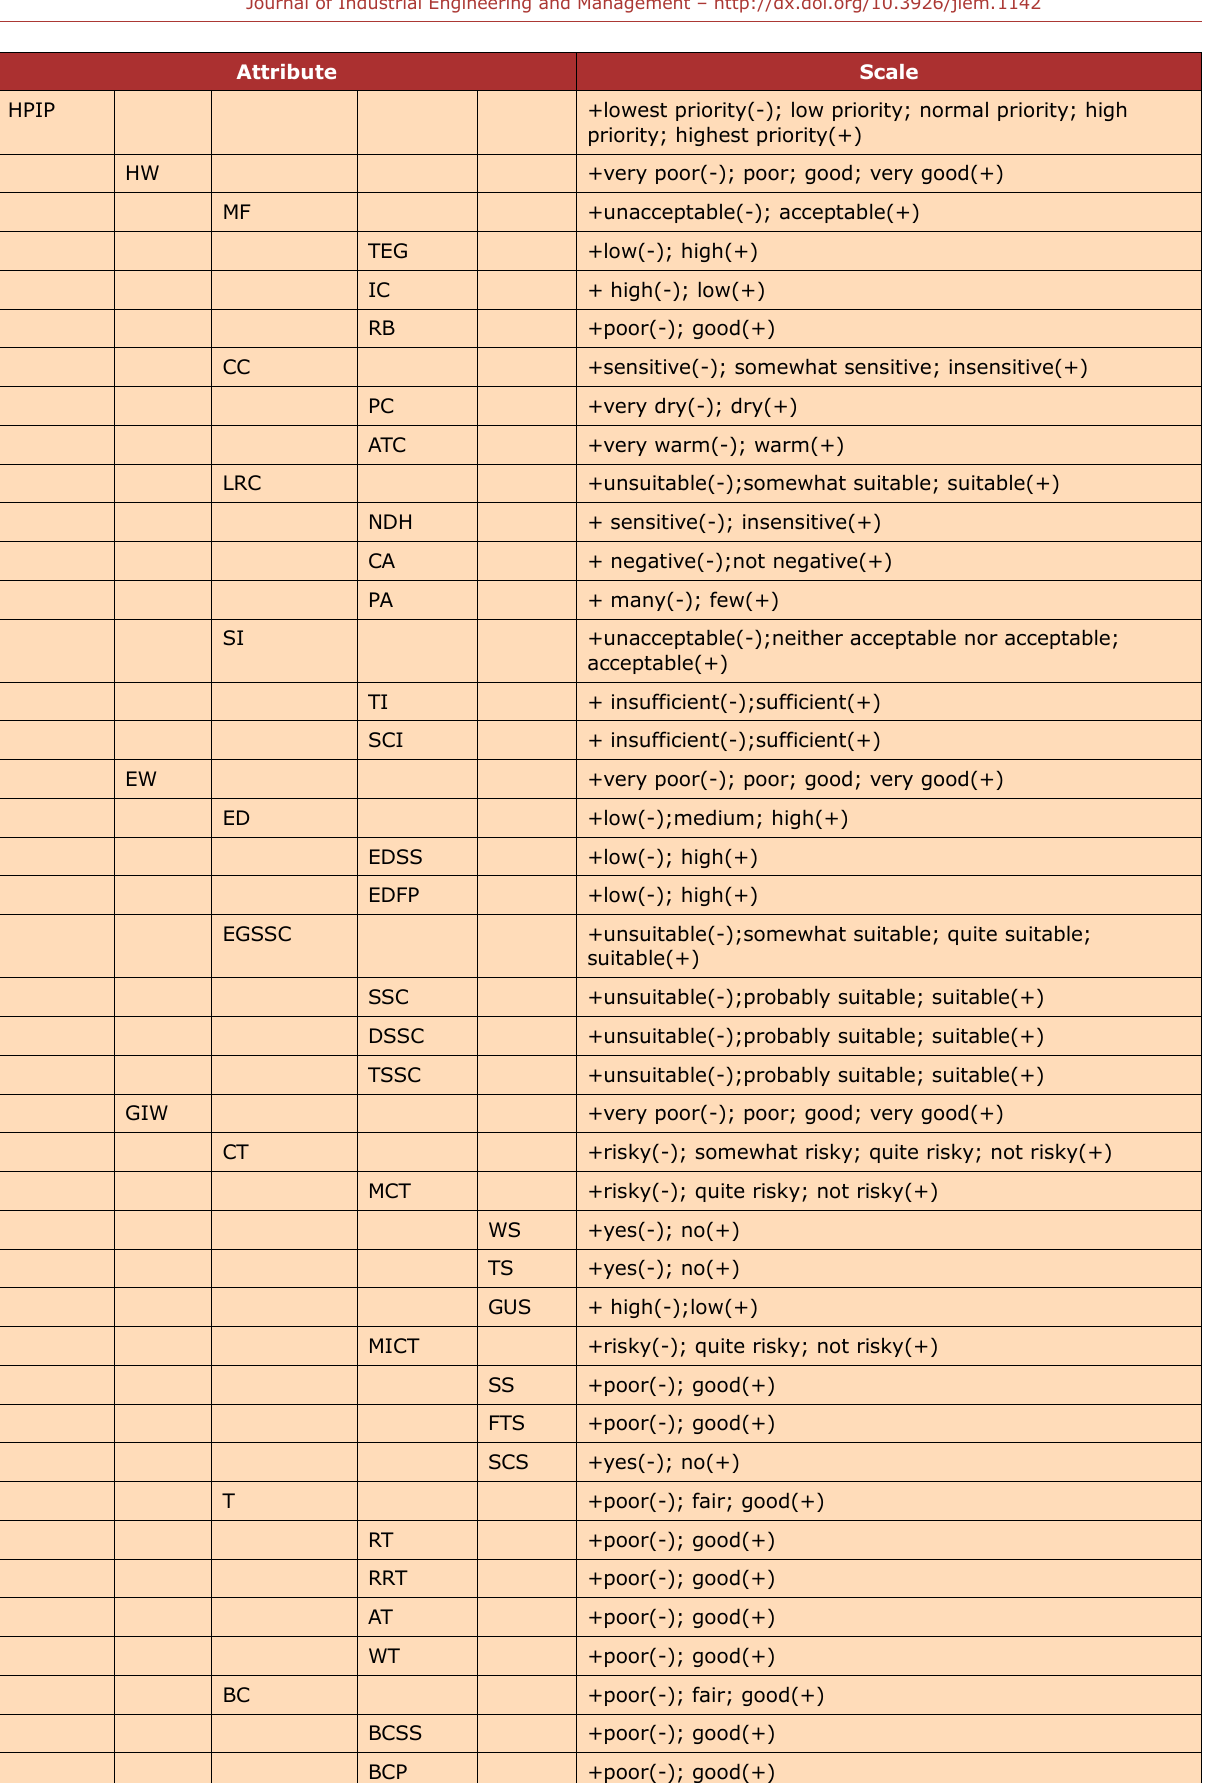
Table 1. The structure and the scales of the model. Abbreviations : paragraphs above